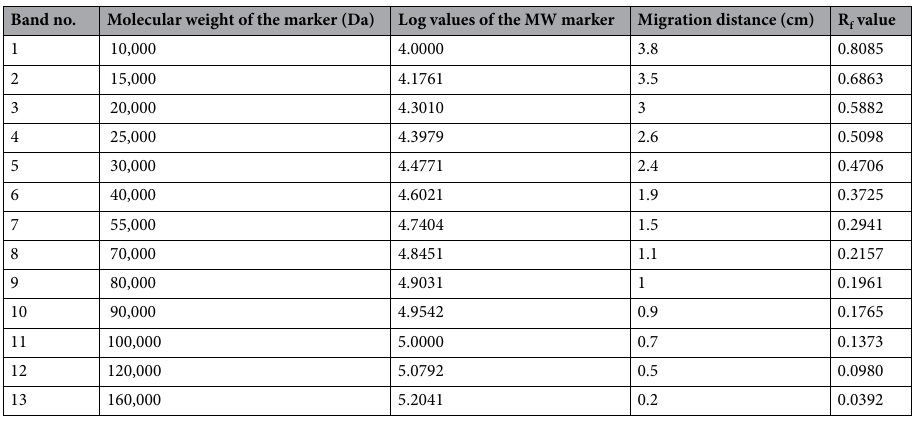
Table 2. Calculated R f values of the molecular weight (MW)